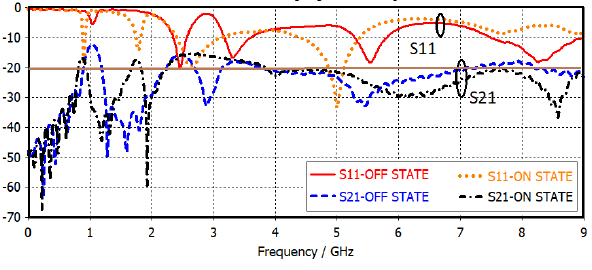
FIGURE 12. Simulated coefficient of the MIMO antenna with/ without decoupling structure at different states